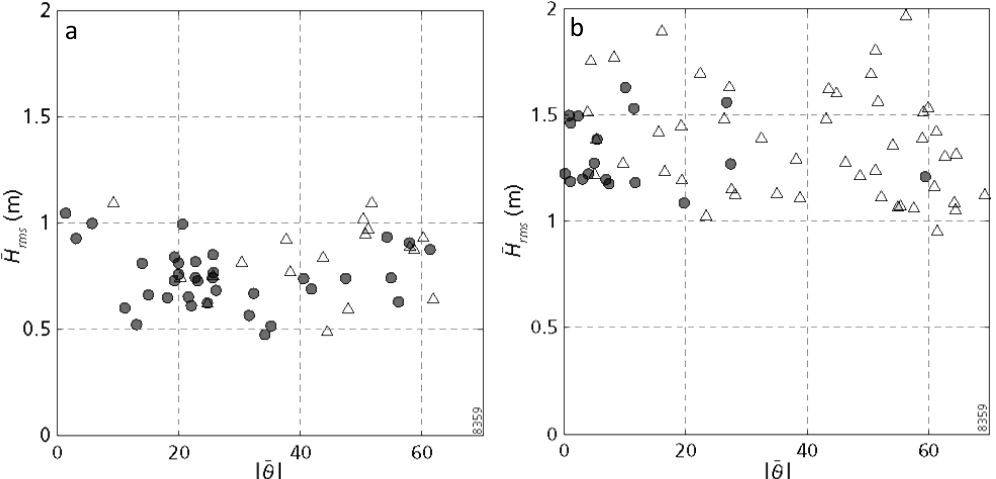
Figure 3. Mean wave conditions during (a) low-energetic and (b) moderately energetic downstate (circles) and upstate (triangles) transitions of the outer bar, showing ¯ H rms versus |¯ θ | . A downstate transition corresponds to the further development of rip channels, an upstate transition to a sandbar straightening. Adapted from: Price and Ruessink (2011).